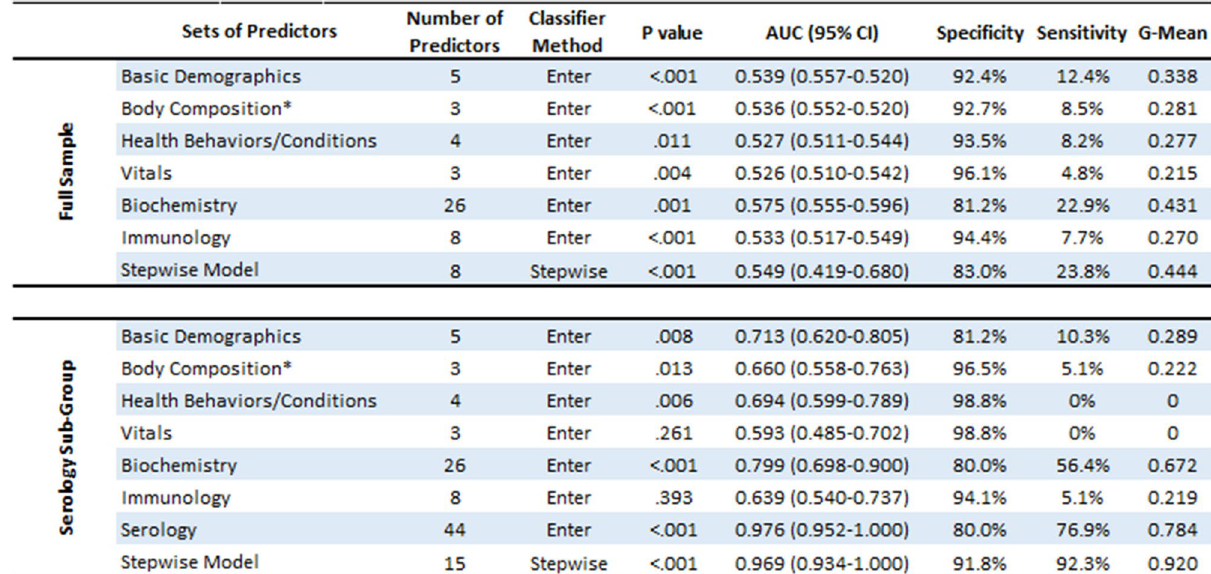
Table 3. Sets of predictors used to predict classification of COVID-19 test cases as negative or positive. Area Under the Curve (AUC); Confidence Interval (CI); Geometric Mean (G-Mean). Non-parametric bootstrapping (1000 iterations, 95% CI) was used for robust estimation. P values less than 0.05 were considered significant. “bold” and “italics” shading are used to distinguish between predictors that loaded for a given model. a Due to several variables representing the same construct (i.e., being multicollinear), body composition consisted of: whole-body water mass; whole-body fat mass; whole-body non-fat mass (i.e., muscle,